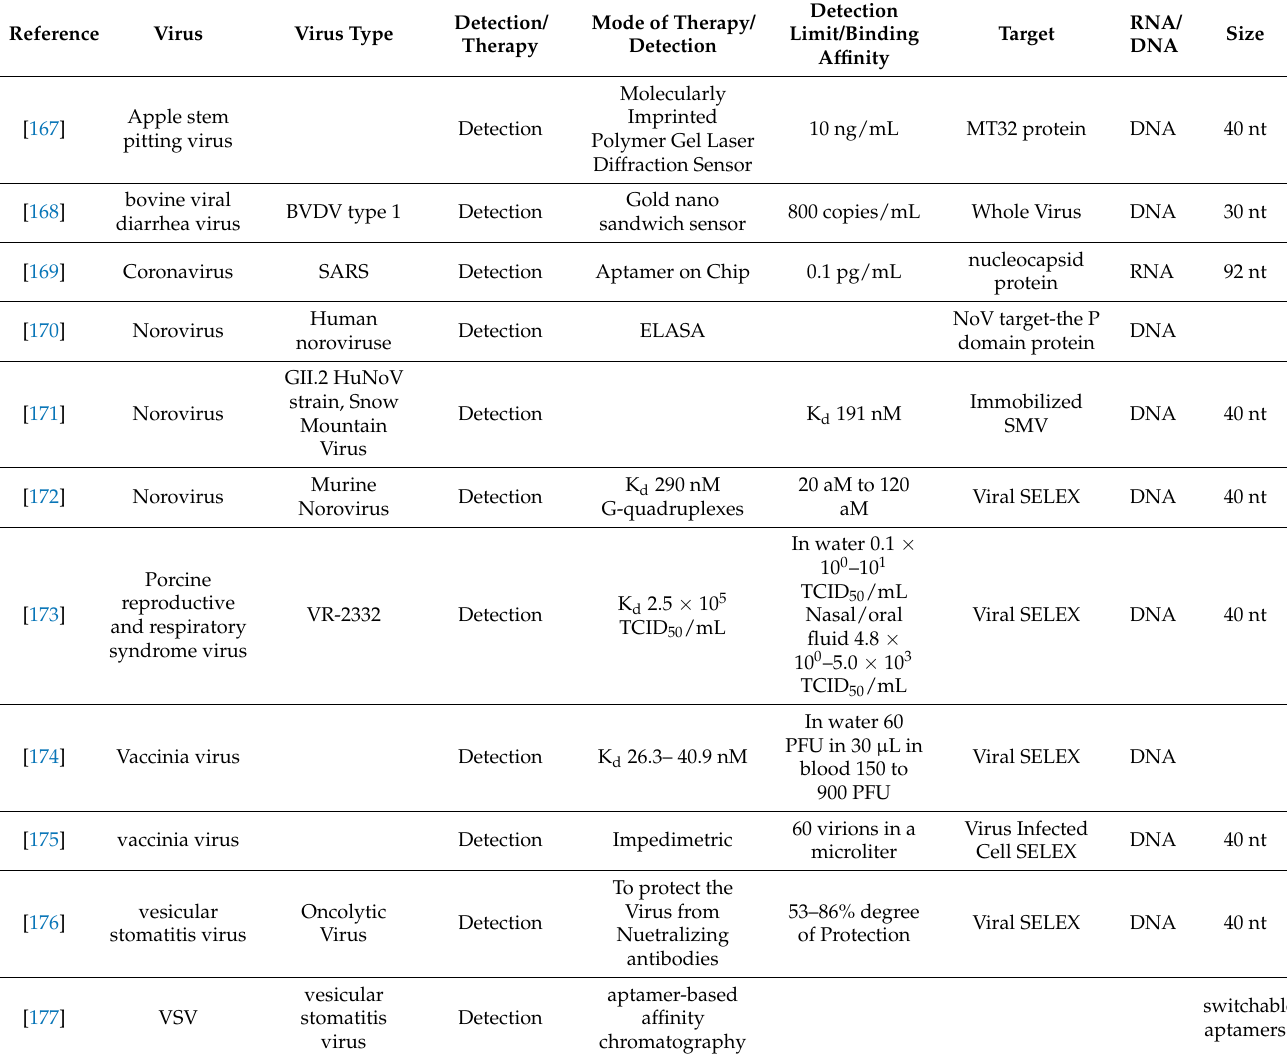
Table A4. List of aptamers for various other viruses which have not been discussed in this